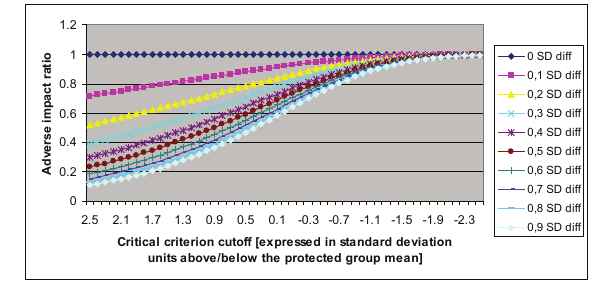
FIGURE 4 Adverse impact ratio as a function of the criterion cut-off in the protected group’s predicted criterion distribution and the difference in the mean predicted criterion performance: expressed in standard deviation units [ ρ XY = 0,90] 12